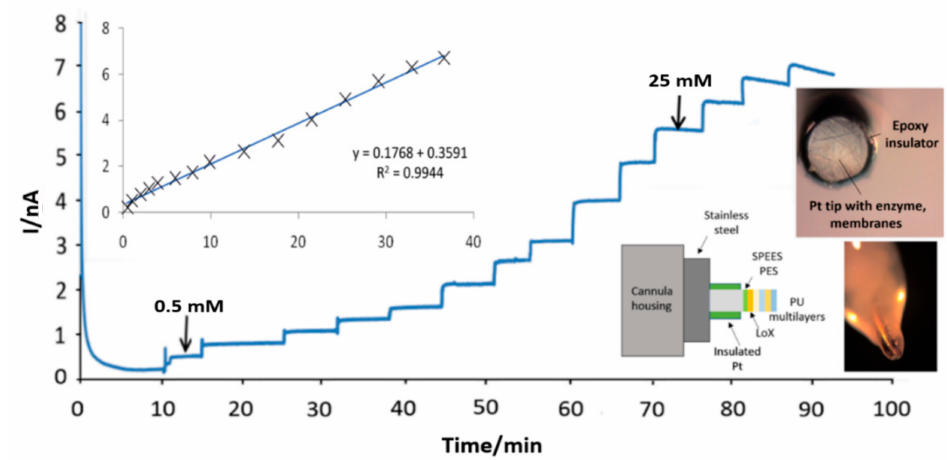
Figure 4. Lactate needle electrode dynamic responses (0.5–36 mM lactate) in stirred PBS solution shown for electrode made with inner SPEES PES membrane deposited from 20% DMSO solution, albumin crosslinked lactate oxidase (LOx) from Pediococcus sp (25 U/mg) as the enzyme layer and final a final coating sequence of four polyurethane layers deposited from 10, 20, 30 and 40% THF solution. Inset shows the resulting lactate calibration plot, again to 36 mM lactate. Schematic shows side view of the needle electrode with the various enzyme and covering polymer layers over an insulated Pt wire retained in stainless steel tubing as pseudoreference. The cannula housing for the assembly serves as a conduit for needle electrode tissue insertion. The light microscopy images show two different electrode needle tips with the completed polyurethane